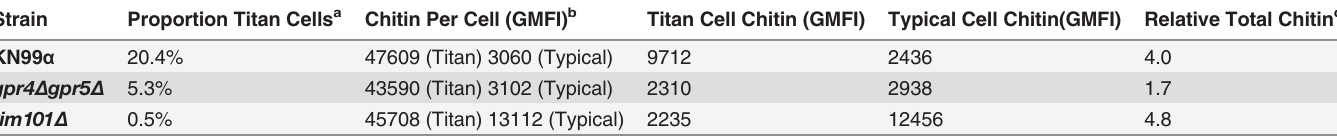
Table 2. Differences in total chitin due to cell